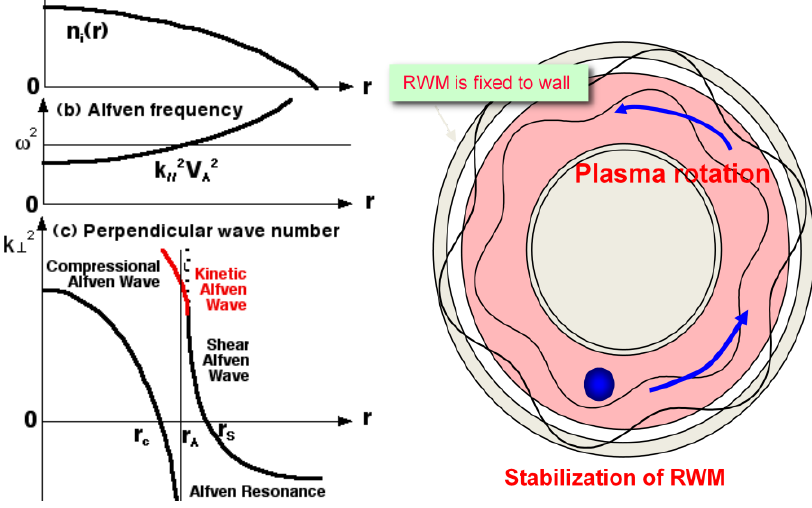
Figure 27. Schematic diagram of Alfven wave resonance and mode conversion to Kinetic Alfven Wave (KAW) indicating existence of shear Alfven wave continuum (left) [139] and schematic figure of plasma stability under resistive wall (right). The resistive wall mode (RWM) is fixed to the wall while plasma is moving in the toroidal direction. So in the moving frame, RWM is regarded as traveling wave by the